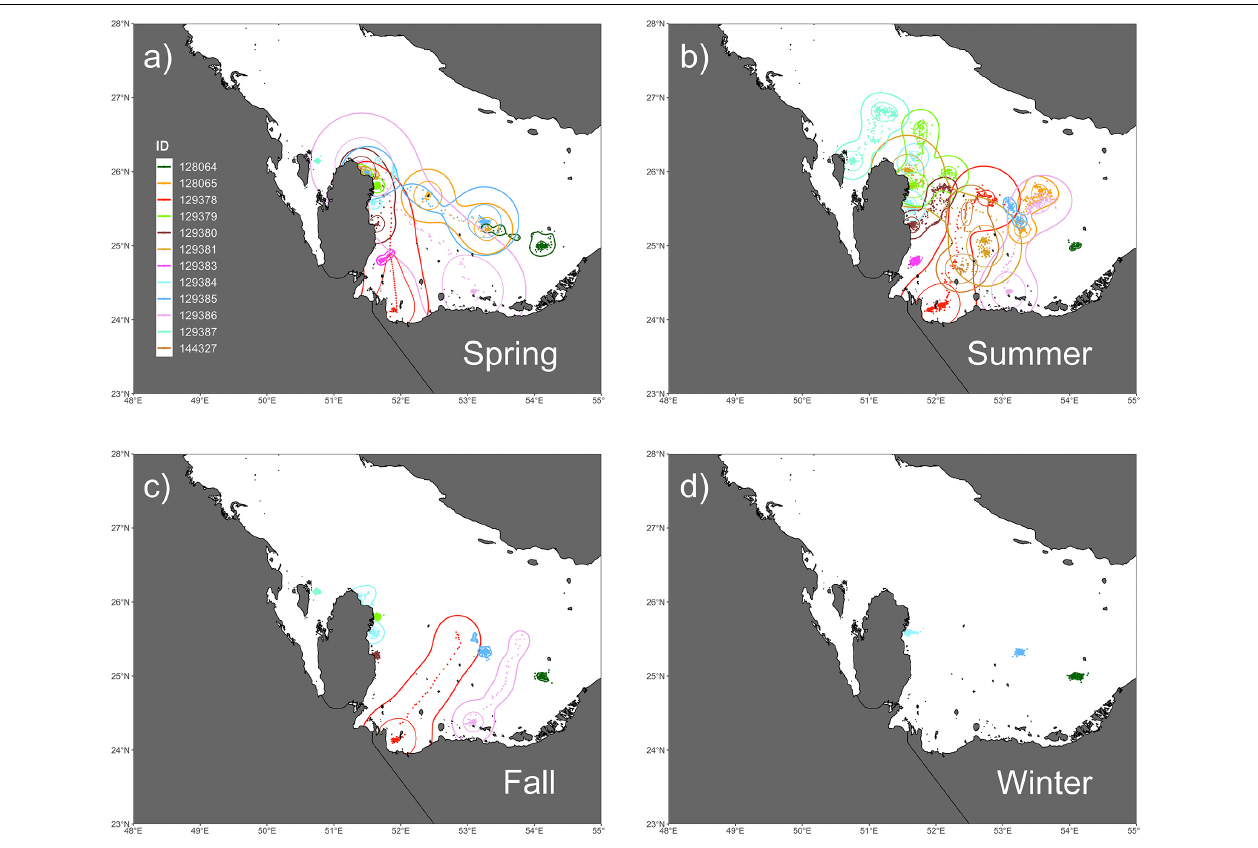
FIGURE 2 | Seasonal trends in space-use as measured by utilization distributions (UDs) by kernel density estimation (KDE) for (a) spring, (b) summer, (c) fall, and (d) winter. Spring UDs encompassed the greatest collective area of any season and primarily shows post-nesting movements to foraging sites. In the summer, the majority of hawksbills undergo migrations to deeper waters in the middle of the Gulf. Movements in the fall are much more restricted when compared to spring and summer, where the return migrations by two individuals (129378, 129386) can be seen at the start of the season. Winter movements are the most restricted and show little no